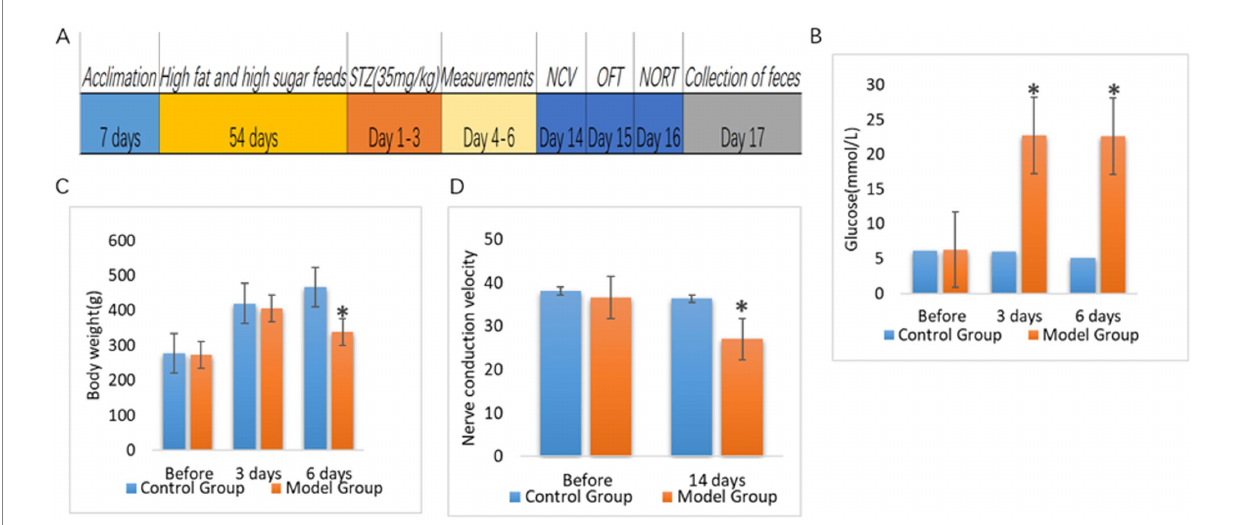
FIGURE 1 Comparison of blood glucose, body weight and nerve conduction velocity between control rats (Control Group) and rats with diabetic peripheral neuropathy (Model Group). (A) Timeline of this study. After 7 days of acclimatization feeding, rats in the experimental group were started on high-fat, high-sugar feeding for 8 weeks. After 8 weeks, rats in the experimental group were injected intraperitoneally with STZ (35 mg/kg) for 3 consecutive days to induce diabetes, and rats in the control group were injected intraperitoneally with saline (35 mg/kg). Body weight and blood glucose levels were measured from day 4 to day 6 after the start of injection, and nerve conduction velocity was measured in the rats on day 14. (B) Blood glucose levels ( p < 0.05). (C) Body weight ( p < 0.05). (D) Sciatic nerve conduction velocity ( p < 0.05). * p <0.05.